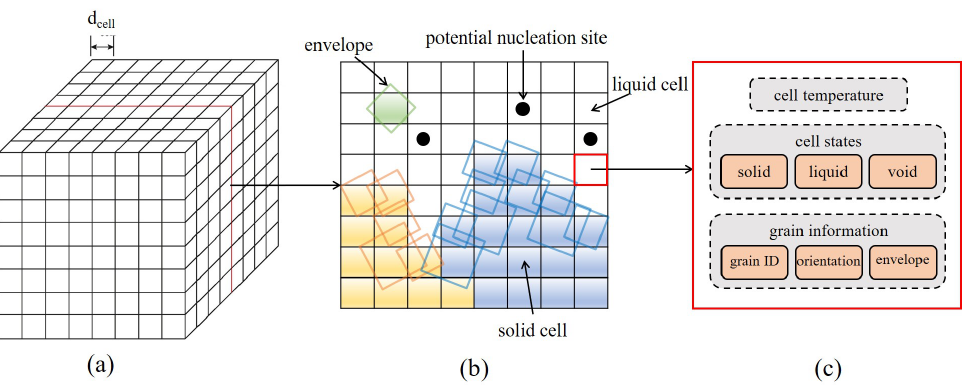
Figure 2. Grain structure evolution model: ( a ) a regular network of cellular automata model, where d cell is the cell size, ( b ) a cross-section view of the network, and ( c ) the information carried by each cell during the